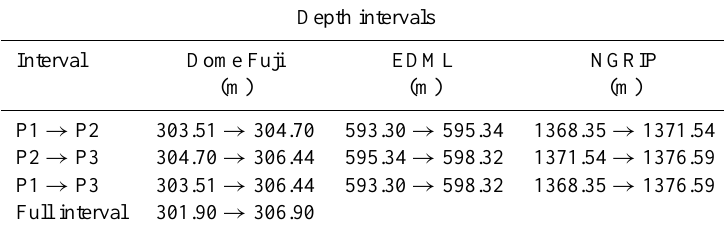
Table 1. The depth intervals defined by the characteristic acidity spikes P1, P2, and P3 in the ice cores (see Figs. 2 and 5).